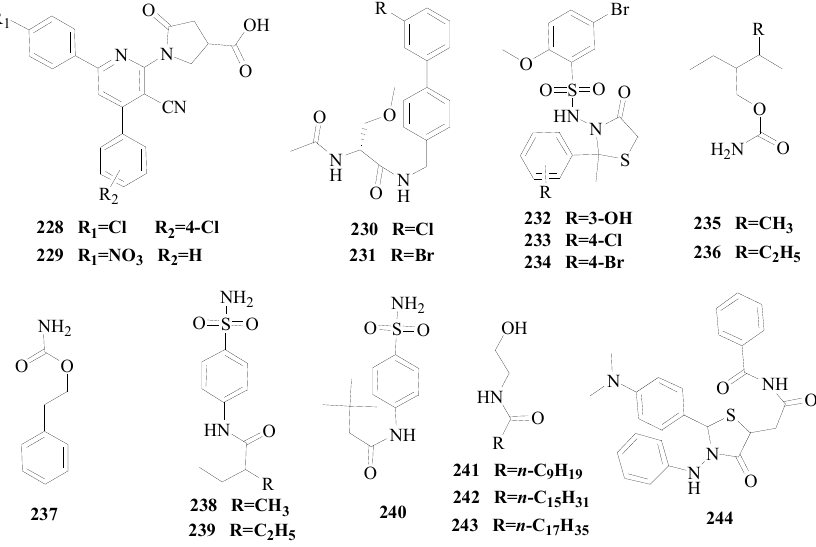
Figure 13. Structures of compounds 228 – 244 .